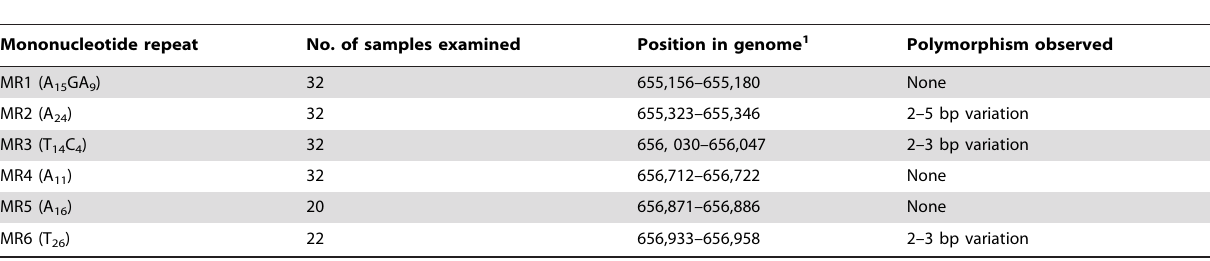
Table 2. Polymorphism among mononucleotide repeats near the TYMS promoter.